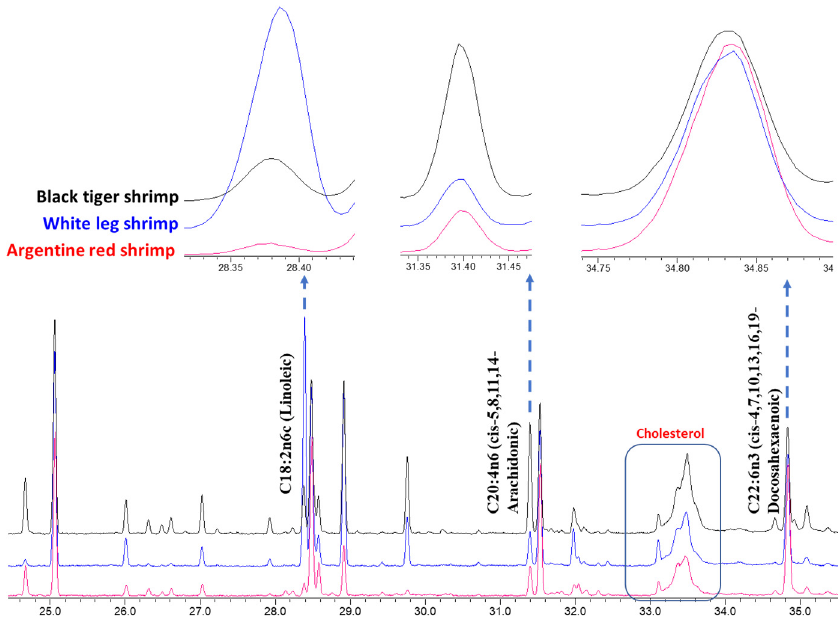
Figure 3. The representative gas chromatography (GC)-total ion chromatogram (TIC) profiles of fatty acid methyl esters (FAMEs) from the edible flesh of three shrimp species. The significant variation in fatty acid composition among black tiger, white leg, and Argentine red shrimp are shown.